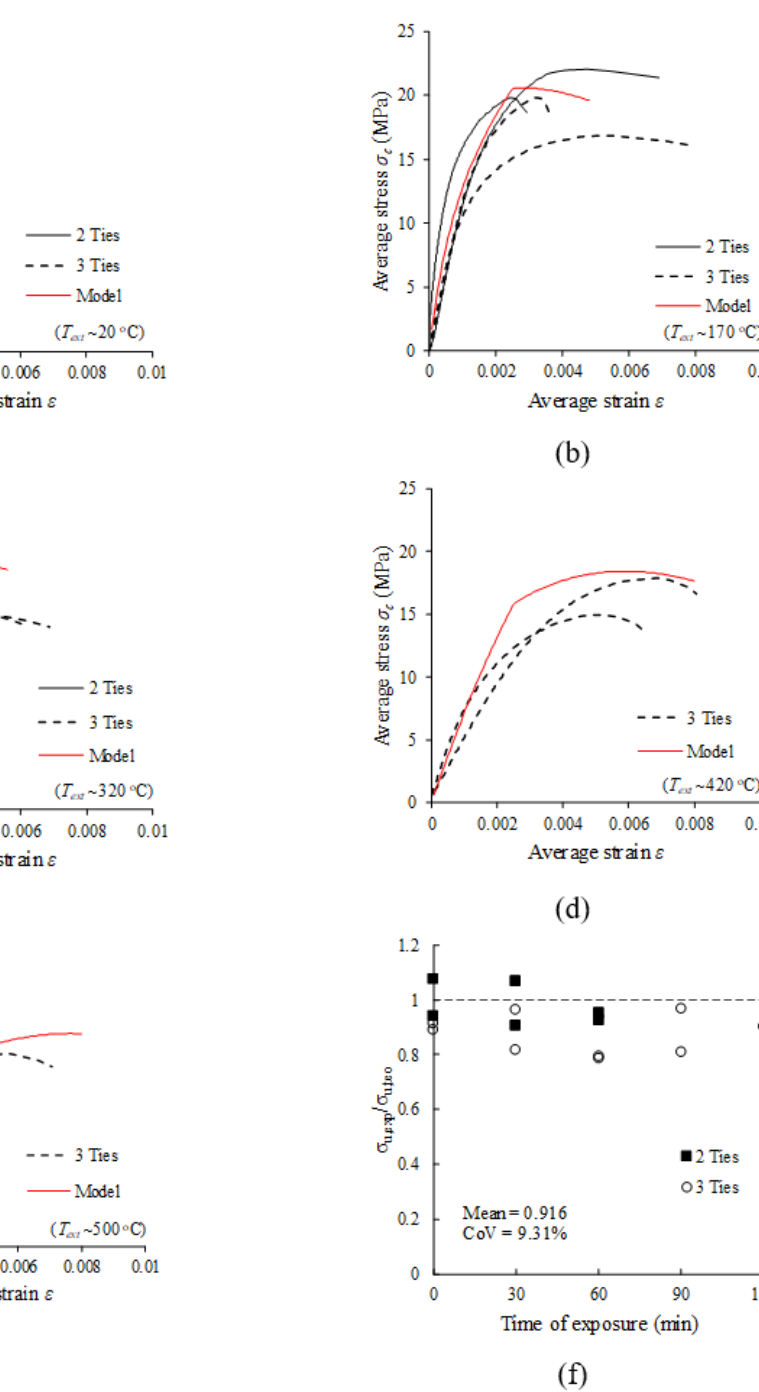
Figure 11. Comparison between experimental and analytical results: a) room temperature; b) 30 min of exposure; c) 60 min of exposure; d) 90 min of exposure; e) 120 min of exposure; f) ratio between experimental and theoretical strengths ( σ u,exp / σ u,teo